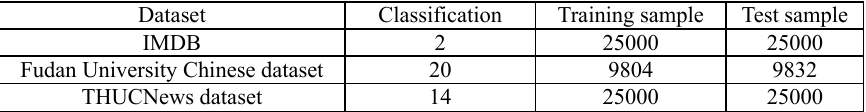
Table 4. Dateset